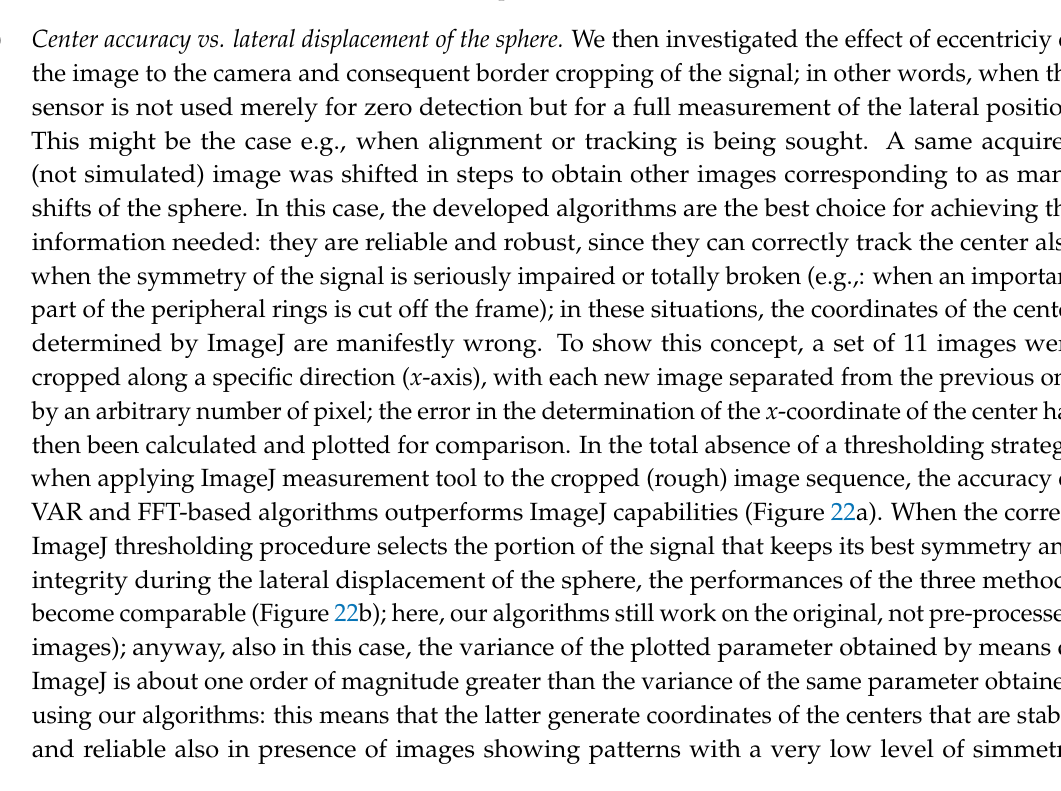
Figure 21. Δ vs. sphere-camera distance.